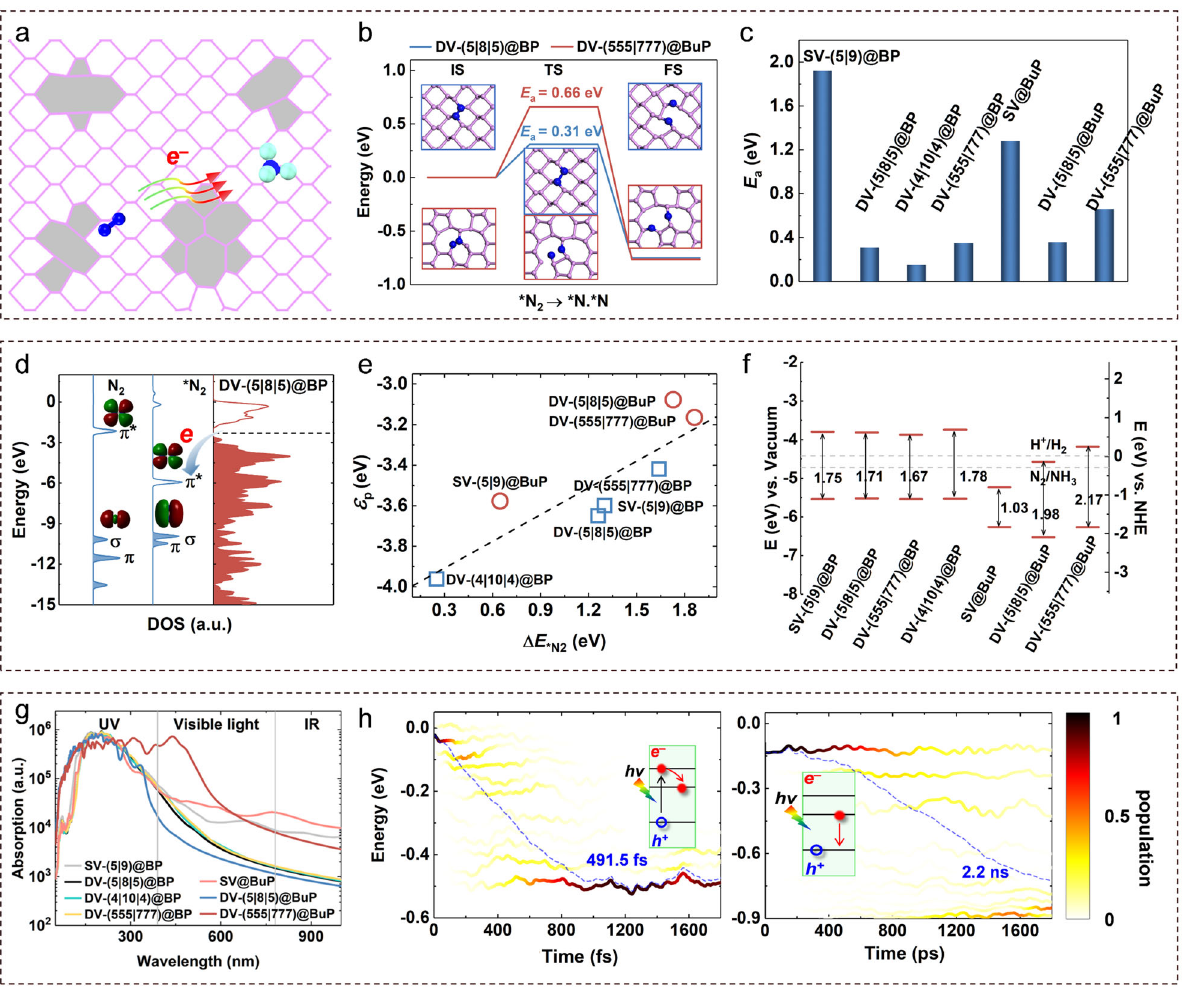
Fig. 11 Mechanism and carrier dynamics of N 2 fi xation on defective black phosphorene. a Schematic illustration of N 2 fi xation on the defective black phosphorene. b Transition states and c kinetic barriers of N 2 dissociation on defective phosphorene. d Orbital interaction between absorbed N 2 molecule and DV-(5 | 8 | 5) of black phosphorene. e The p orbital centers of defective phosphorene as a function of the adsorption energy of N 2 . f Band edge positions with respect to the redox potentials of NRR and g optical absorption spectra of various defective phosphorene. h Time-dependent averaged energy evolution (blue dashed lines) of hot electron relaxation and recombination in DV- (5|8|5) of black phosphorene calculated by using the fewest switches surface hopping and decoherence induced surface hopping methods, respectively (images are adapted from ref. 320 , Copyright © The Royal Society of Chemistry